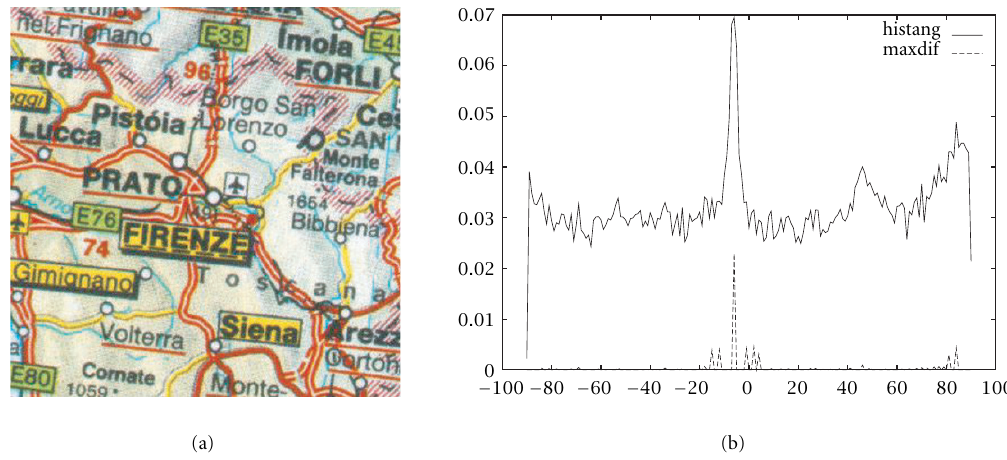
Figure 6: A rotated map image (a) and the corresponding plot of λ(θ i ) , solid line, and p(θ i ) , dashed line. The maximum of both λ(θ i ) and p(θ i ) corresponds to the true text orientation ( − 6 degrees).